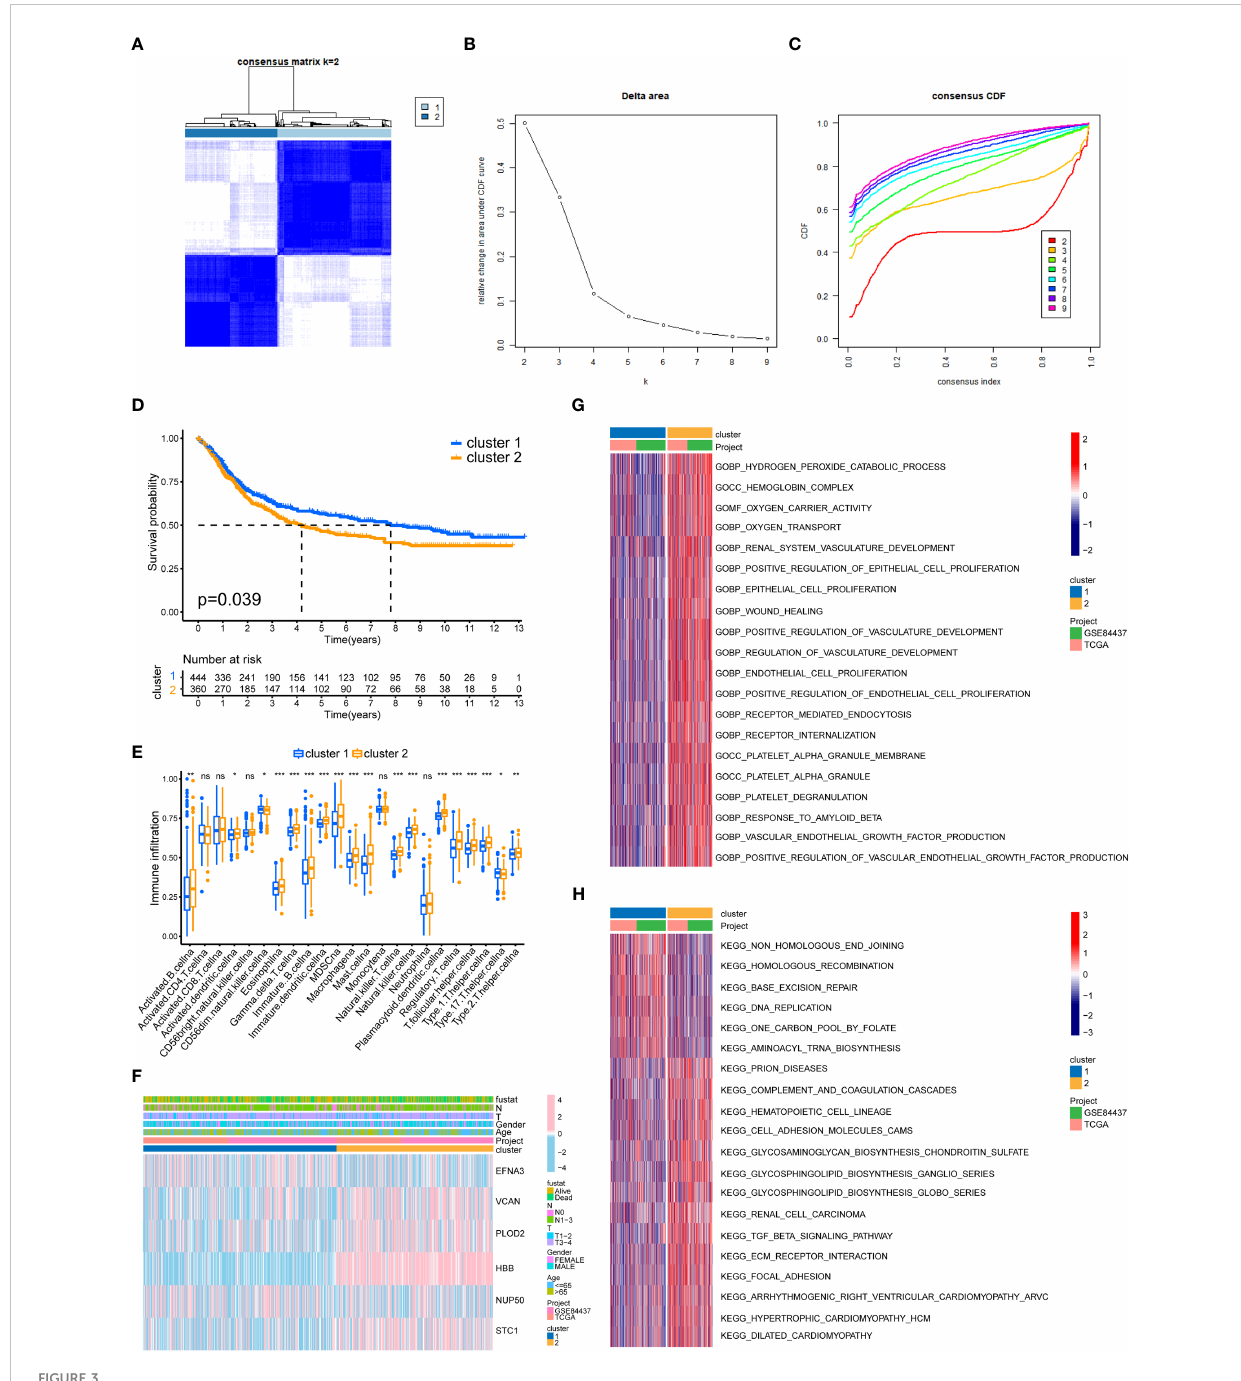
FIGURE 3 GC classi fi cation of lactylation-related genes. (A) Changes in the length and inclination of the cumulative distribution function (CDF) curve when k=2-9. (B) Area under the CDF curve when k=2-9. (C) GC samples were divided into two tumor clusters. (D) Kaplan – Meier survival curves of the two clusters. (E) Immune cell in fi ltration of the two clusters. *p<0.05; **p<0.01; ***p<0.001; ns, no signi fifi cance. (F) Heatmap of GC classi fi cation, lactylation-related genes, and clinicopathological characteristics. (G) GO enrichment analysis of the two GC clusters. (H) KEGG enrichment analysis of the two